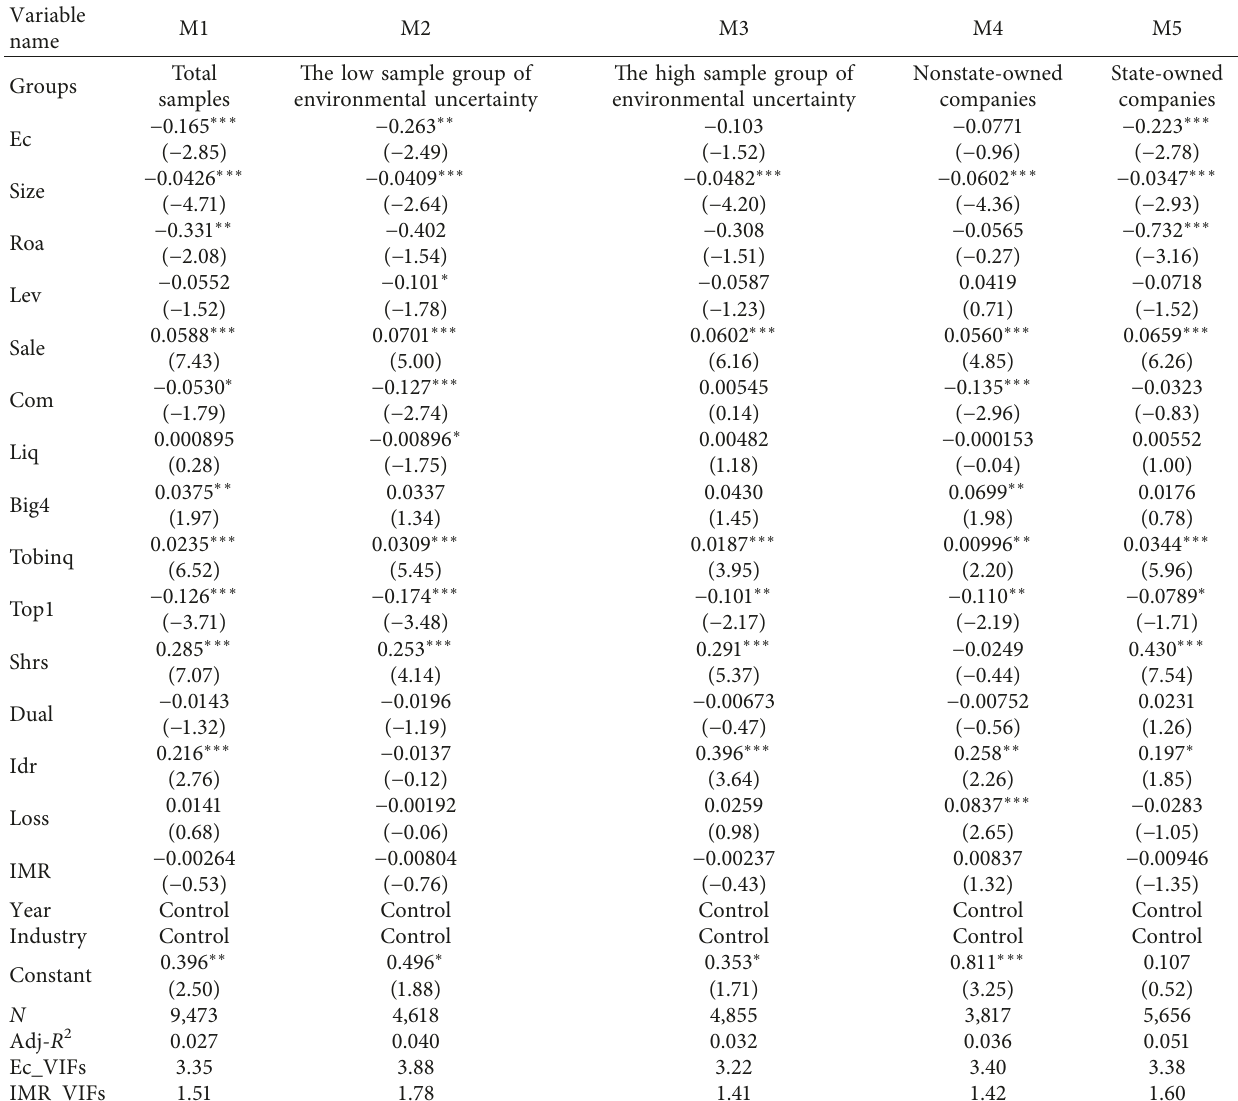
Table 7: The results of Heckman’s stage 2